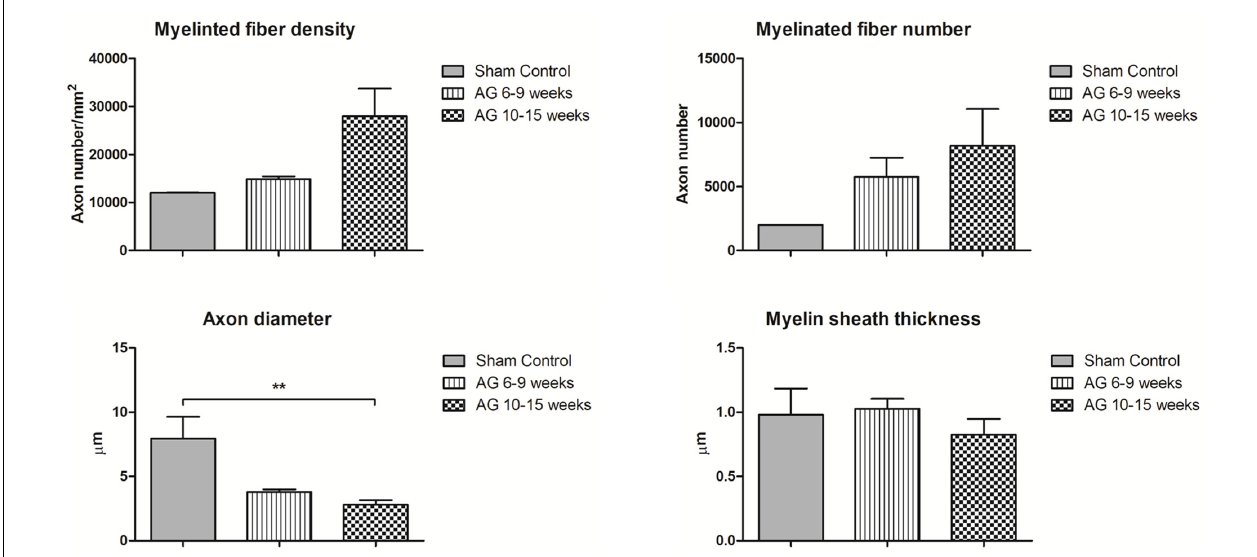
FIGURE 3 | Quantitative analysis of the neuronal morphology based on different parameters emerging from the histomorphometric evaluations. The myelinated fiber density (number of axons per mm 2 ), myelinated fiber number, axon diameter ( µ m) and myelin sheath thickness ( µ m) are compared between sham control and autografts (AG) at different time points. One way ANOVA for nonparametric data and Dunns’ post hoc correction was performed. Data are reported as mean ± SD, ∗∗ p < 0.01.